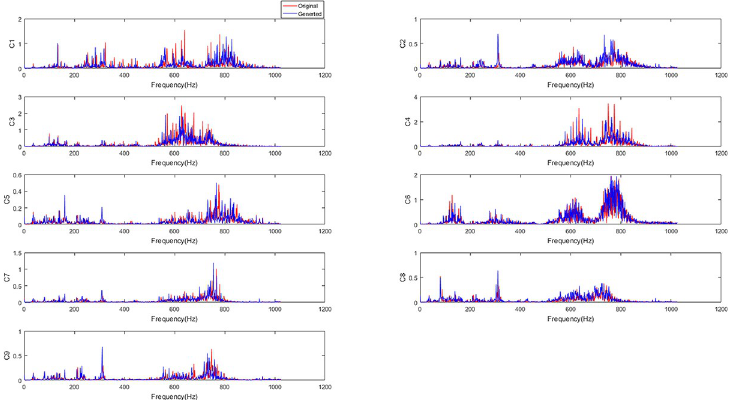
Fig 17. The spectrum of original samples and corresponding generated samples under nine fault